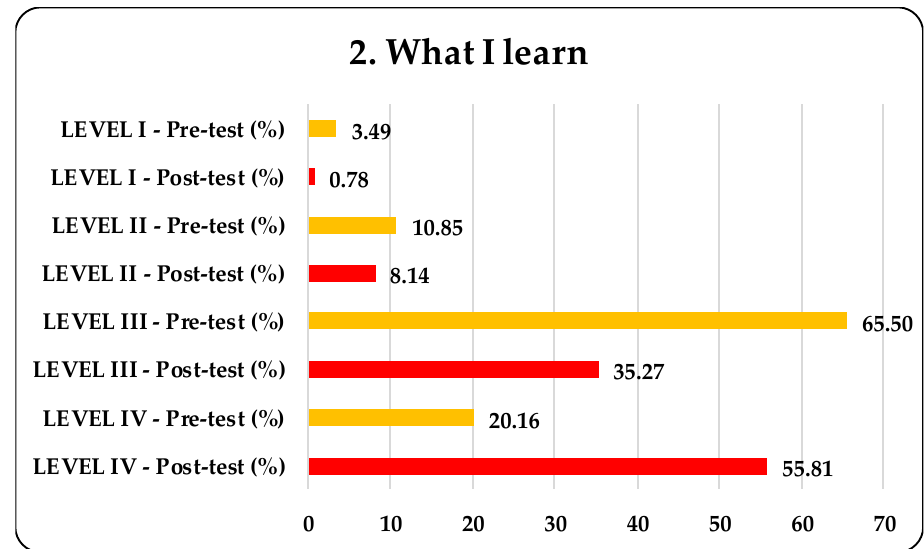
Future Internet 2021 , 13 , x FOR PEER REVIEW Figure 7. Levels of achievement of the second dimension: Why I learn (%). Figure 7. Levels of achievement of the second dimension: Why I learn (%).